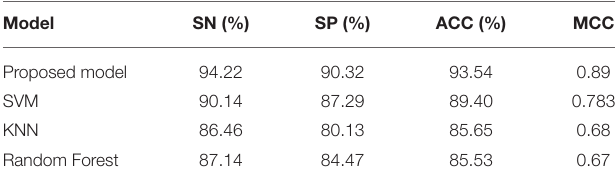
TABLE 2 | Experimental comparison